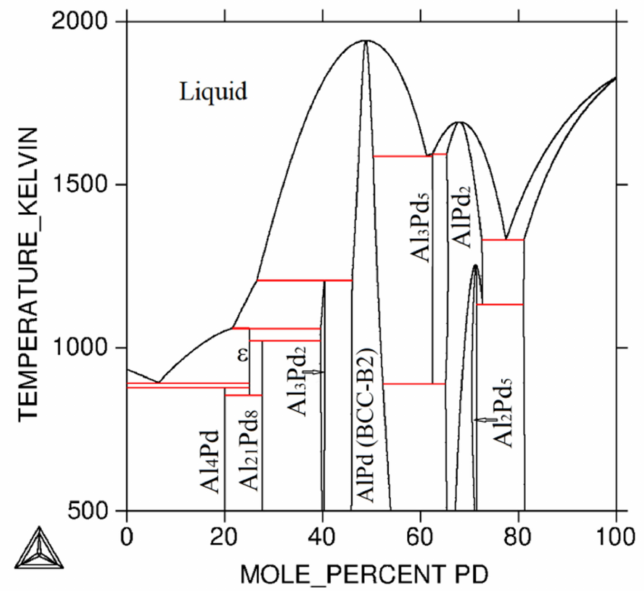
Figure 3. Phase diagram of the Al–Pd binary